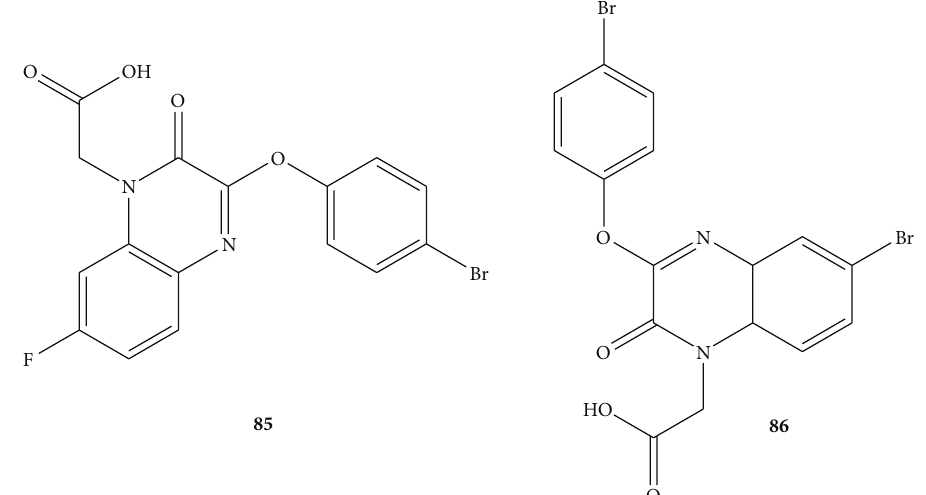
Figure 36: Chemical strucure of compounds tested.